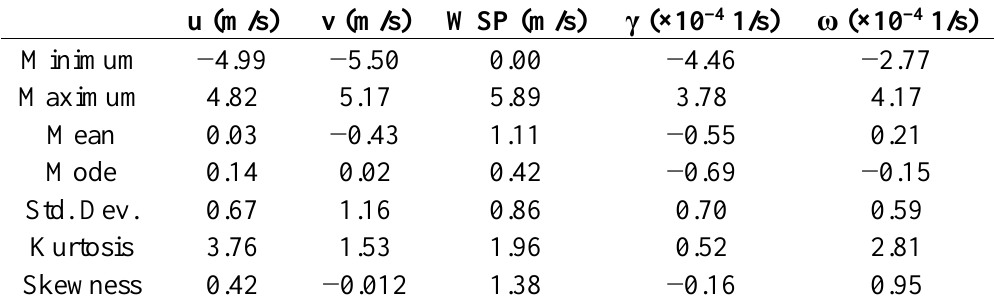
Table 5. Statistics of the wind state parameters. Period